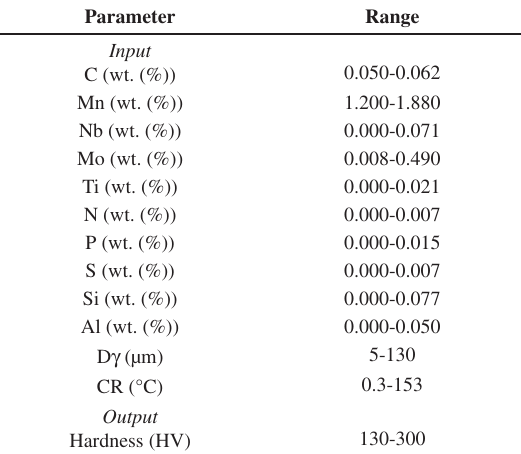
Table 1. Chemical composition of the microalloyed steels. Ref.